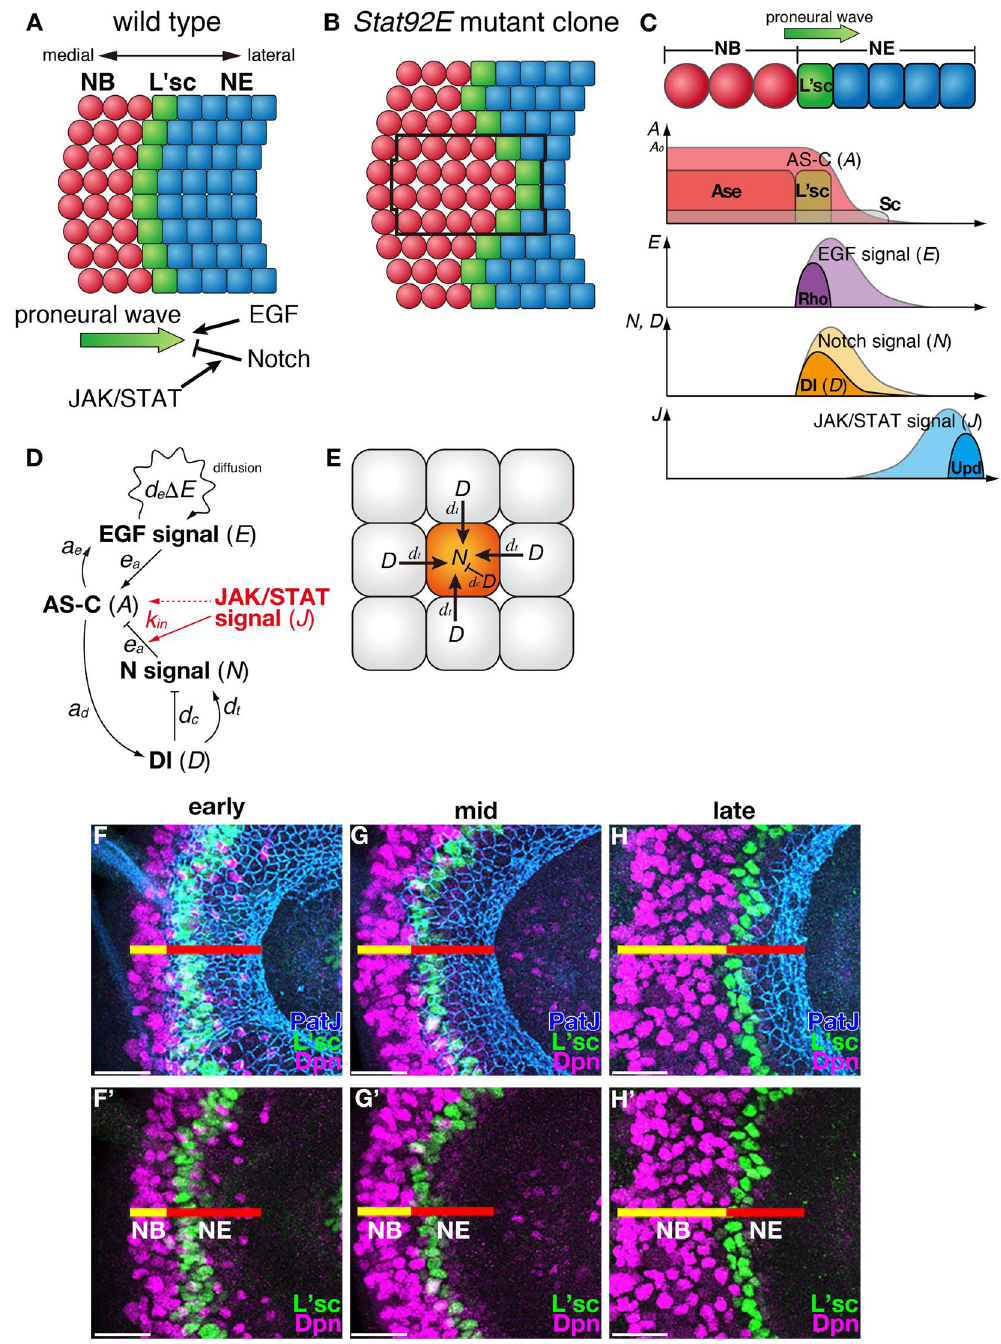
Figure 1. The proneural wave progresses unidirectionally during optic lobe development in Drosophila . ( A ) A schematic of the progression of the proneural wave. The proneural wave sweeps from medial to lateral. L’sc is transiently expressed in the differentiating NEs and defines the timing of the NE-to-NB differentiation. EGF positively regulates the progression of the wave, while Notch and JAK/STAT negatively regulate wave progression through increasing the expression of Notch target genes. ( B ) Summary of the loss-of-function phenotype of the Stat92E mutant clone. ( C ) Schema showing the spatial profile of each signaling activity. ( D ) Schema showing the gene regulatory network including AS-C, EGF, Notch, Dl, and JAK/STAT. ( E ) Lateral inhibition mechanism of Delta/Notch signaling. ( F – H’ ) The progression of the proneural wave in vivo . Control third-instar larvae at ( F ) 114-126, ( G ) 126–138, ( H ) 138–150 hours after egg laying are shown. PatJ (blue, NE), L’sc (green, proneural wave), Deadpan (Dpn, magenta, NB) are shown. ( F’ , G’ , and H’ ) L’sc (green) and Dpn (maenta) are shown. Scale bars, 20 μ